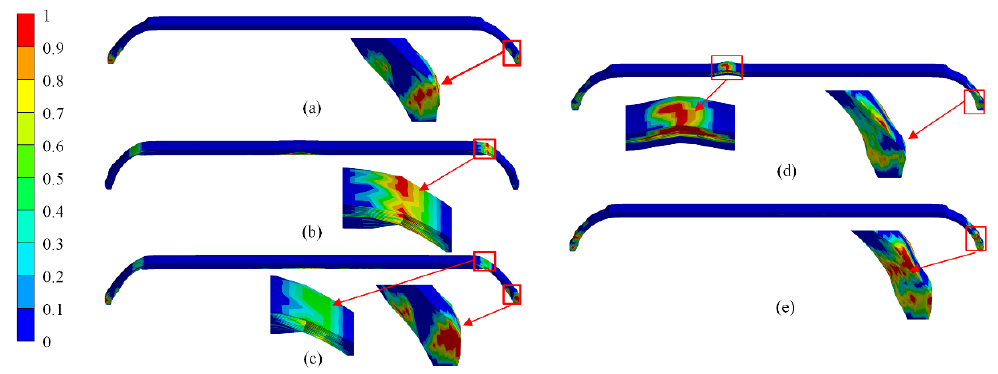
Figure 15. Comparison of numerical results of fiber damage at the burst pressure: ( a ) Scheme C_3, ( b ) Scheme C_4, ( c ) Scheme C_5, ( d ) Scheme B_3, and ( e ) Scheme B_5. ( b ) Scheme C_4, ( c ) Scheme C_5, ( d ) Scheme B_3, and ( e ) Scheme